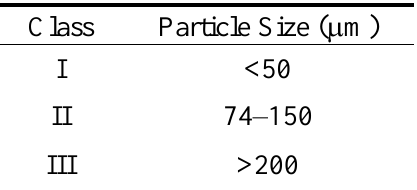
Table 1. Particle size distribution.